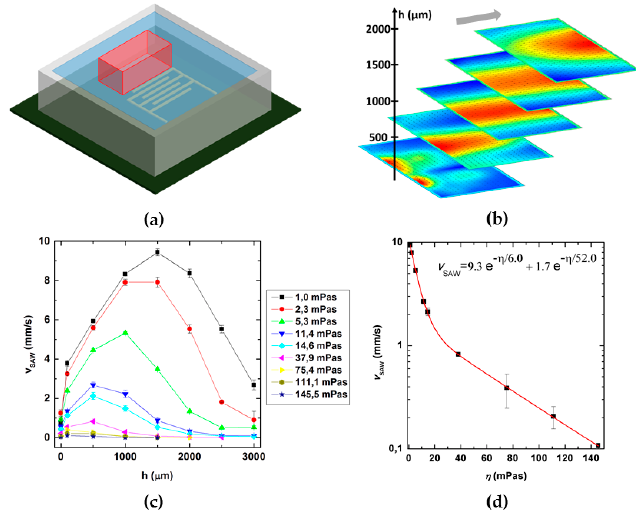
Figure 4. ( a ) Sketch of the used setup. A PDMS wall (grey) is placed on the SAW-chip and filled with a fluid. The red area shows the measured region in front of the aperture starting at the first finger of the IDT; ( b ) Velocity field for different heights, measured by particle image velocimetry (PIV). The position of the jet changes with height. The color scale gives the distribution of the velocity in each layer (blue = minimal, red = maximal). The general in plane flow is from left to right as indicated by the grey arrow; ( c ) Mean SAW velocity from ( b ) dependent on the height in the fluid for different viscosities. The maximal velocity decreases with increasing viscosity. The overall shape of the graph is caused by a viscosity dependent Rayleigh angle and fixed positions of the analyzed region; ( d ) The maximal SAW velocity declines bi-exponentially with increasing viscosity of the fluid. The data point and error bars represent the mean and the standard deviation respectively, of at least three experiments.